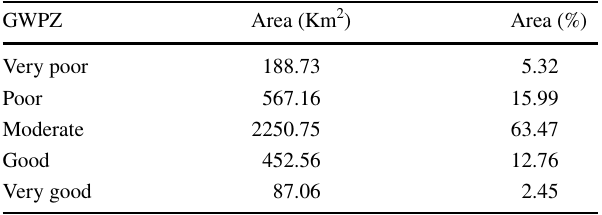
Table 2 Groundwater potential